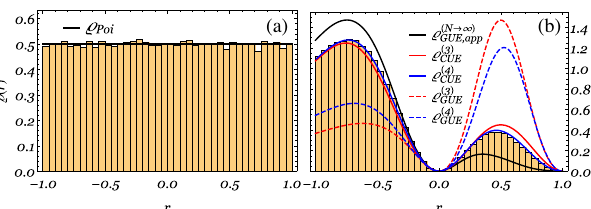
FIG. 2. Comparison of numerical results and analytic predictions for the case of a real spectrum. (a) Yellow bars: Histogram of the ratios for 10 5 independent levels. Black line: Exact result. (b) Yellow bars: Histogram of the ratios obtained by exact diagonalization (ED) for N ¼ 10 4 GUE matrices. Black line: Approximate GUE result for N → ∞ , given by Eq. (B14), which is valid near r ¼ 0 . Red solid (dashed) line: Exact result for N ¼ 3 CUE (GUE) given by Eq. (B17) [Eq. (B8)]. Blue solid (dashed) line: Exact result for N ¼ 4 CUE (GUE) given by Eq. (B19) [Eq. (B12)]. CUE with N ¼ 3 , 4 yield good Wigner-like